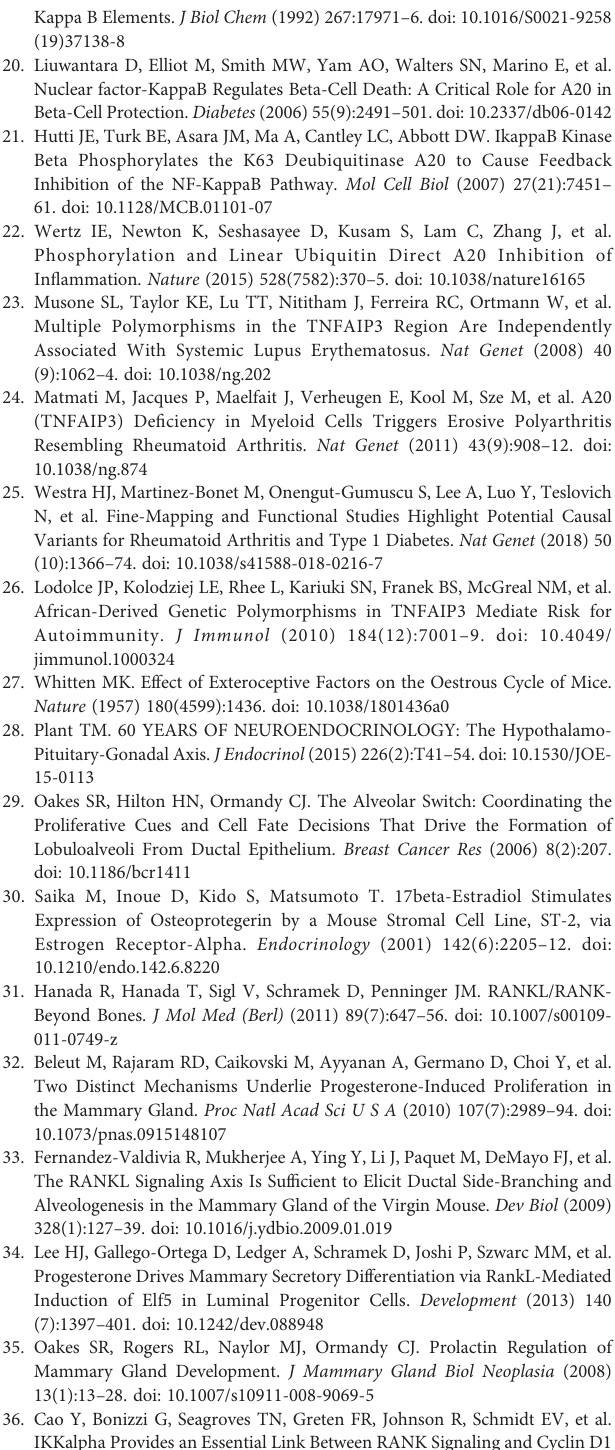
Supplementary Figure 4 | The frequency of CD4+ effector memory cells in the (A) , Spleen; (B) , LN; and (C) , peripheral blood. Frequency of macrophages (CD45+ CD11b+ F4/80+ cells) in the (D) spleen; and, frequency ofICAM1+ macrophages in thespleen (E) .ErrorbarsrepresentS.E.MandStudent ’ sTtestusedforsigni fi cance analysis * = P < 0.05; ** = P < 0.01.